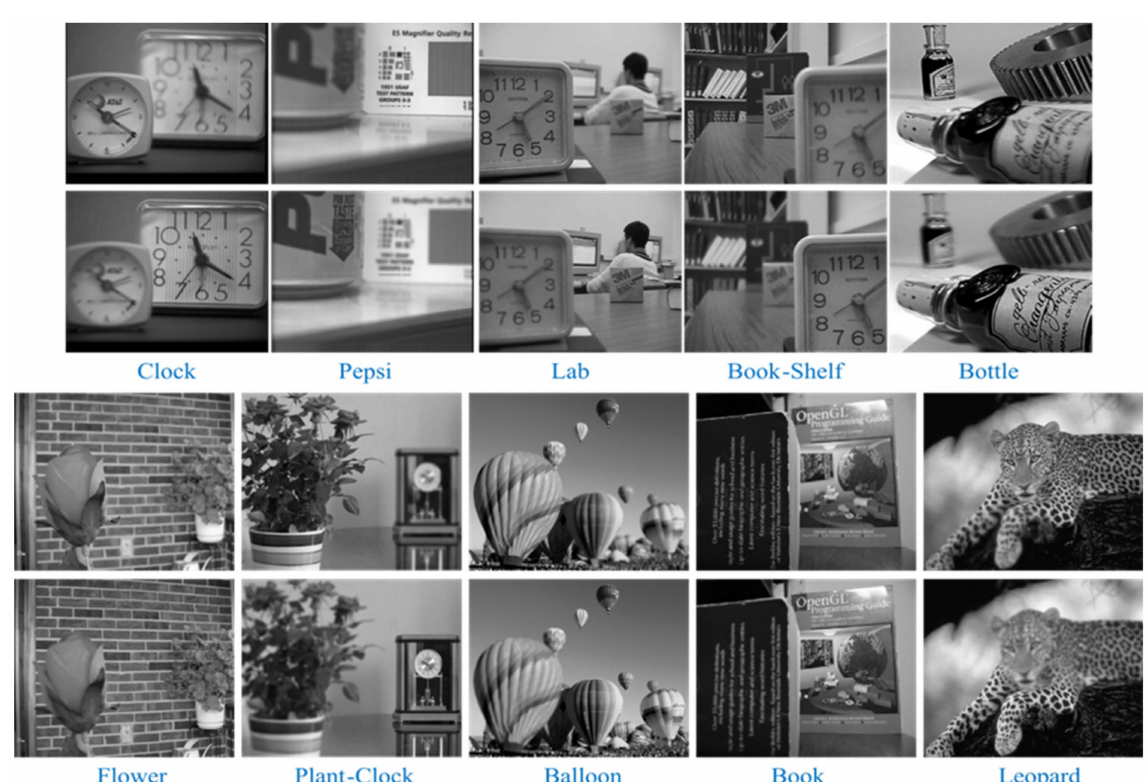
Figure 18. Some multi-focus image